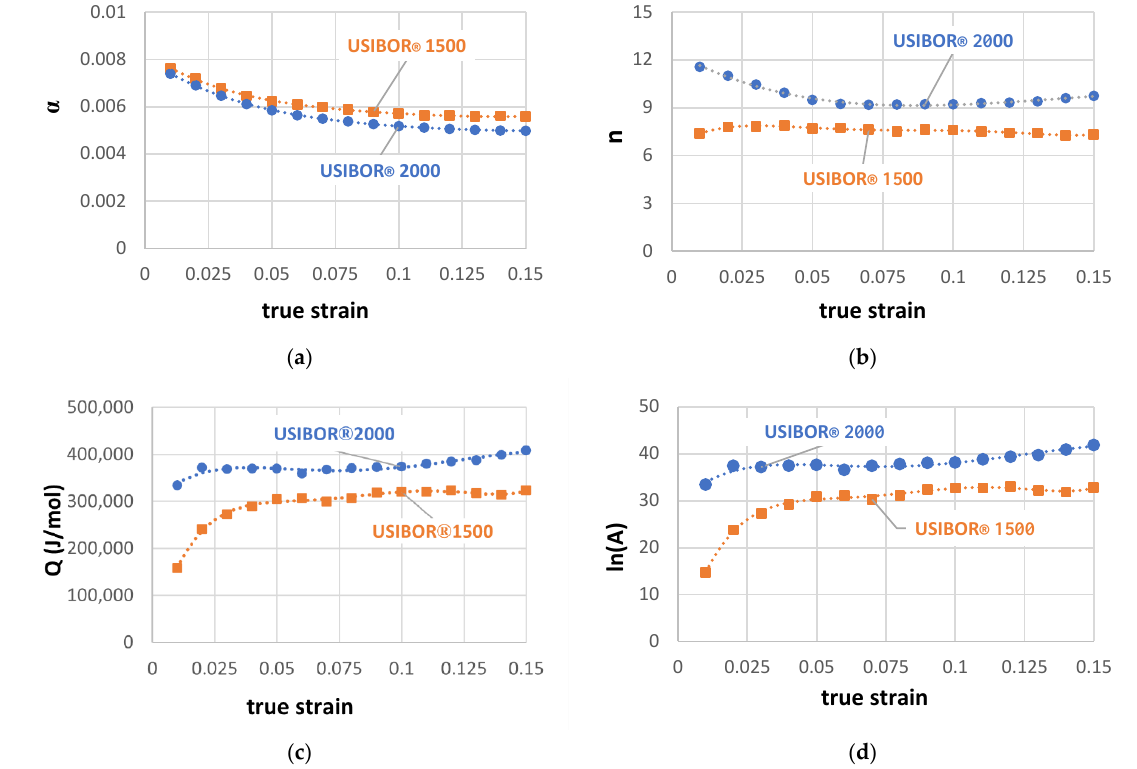
Figure 22. Polynomial fitting curves of material coefficients as a function of strain: ( a ) for 𝛼 ( b ) n, ( c ) Q, and ( d ) ln(A) for both investigated UHSS. The polynomial fitting results are listed in Table 4. Table 4. Polynomial coefficient of α, n, Q, lnA for the USIBOR ® 2000.